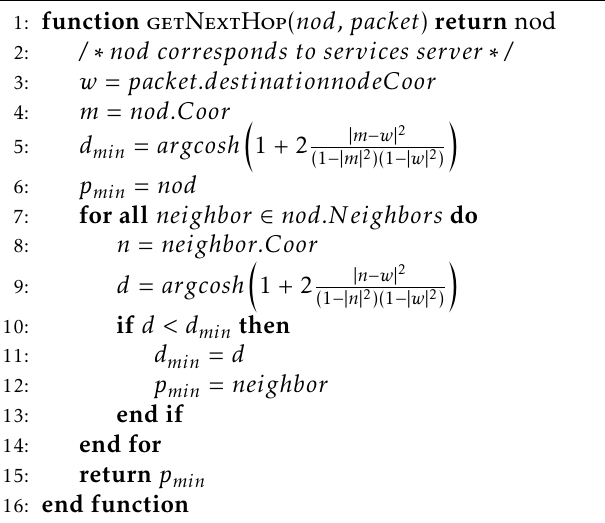
Algorithm 2 Routing a query in the distributed directories.